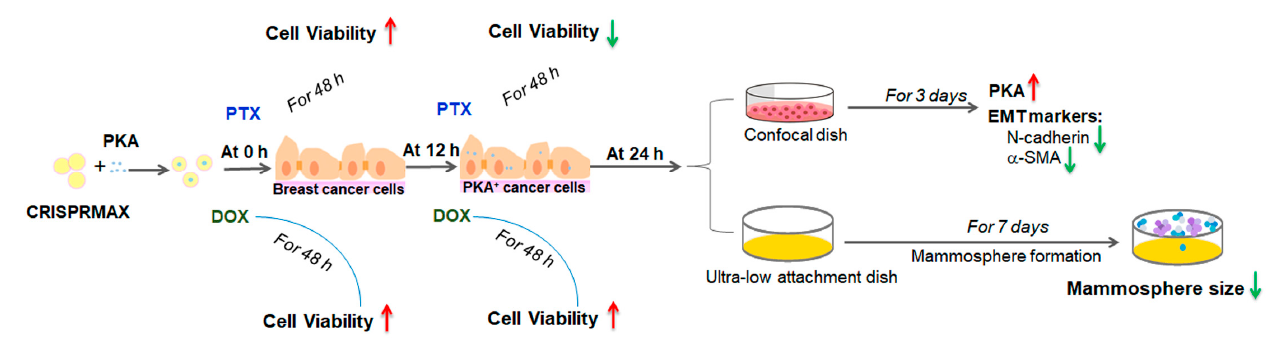
Figure 10. An overview schematic diagram of the study. PKAs and CRISPRMAX had formed as lipid nanoparticle complexes, and then these complexes were added to breast cancer cells. At the same time, chemotherapy drugs PTX or DOX were added (at 0 h transfection time point) into the cells for 48 h, respectively. The WST-1 assay was performed for testing the cell viability. The results showed that compared with the CRISPRMAX-BSAs control group added with the same drug, cell viability increased regardless of whether PTX or DOX was added. When CRISPRMAX-PKAs were added into cells for 12 h, the chemotherapy drug (PTX or DOX) was also added (at 12 h), respectively; the cells were treated for 48 h. WST-1 cell viability results showed that compared with the CRISPRMAX-BSAs control group added with the same drug, the cell viability of the PTX group was significantly decreased compared to the DOX group. Then, 24 h after CRISPRMAX-PKAs delivery into the cells, these cells were digested with trypsin and seeded in a confocal dish for 3 days, followed by immunofluorescence analysis of PKA expression. The results showed that the expression of PKAs was upregulated compared with the CRISPRMAX-BSAs control group; the expression of EMT mesenchymal markers, N-cadherin and α -SMA, was downregulated. Part of the cells were seeded in an ultra-low attachment dish at low density and subjected to mammosphere formation assay; these cells were cultured in mammosphere culture medium and continued to grow for 7 days, the results showed that CRISPRMAX-PKAs-delivered cells-derived mammospheres were decreased in size compared with the CRISPRMAX-BSAs control